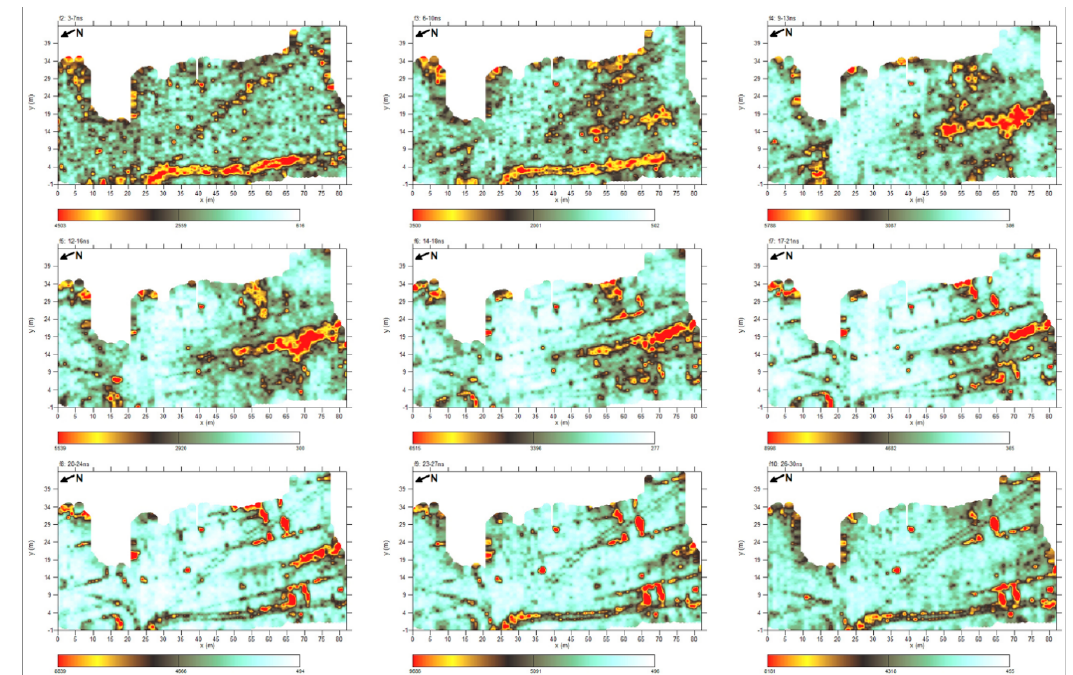
Figure 8. Doclea: a selection of time slices relative to the southern part of the temple of Diana (2 in Figure 10). The colour scale indicates the measured variation of the amplitude of the electromagnetic signal.